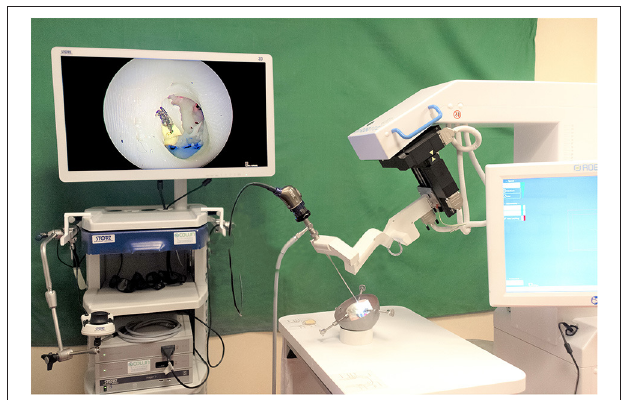
FIGURE 1 | RobOtol System in endoscope holder configuration with an artificial temporal bone. The RobOtol System (Collin, Bagneux, France) is a tele-operated arm that can bear instruments or an endoscope. It can be connected to any HD camera system (Here a Image1 Storz HD endoscopy column, Karl Storz, Tuttlingen, Germany). The robot is composed of a cart bearing the arm, a display screen used to change speed and control settings. The device is driven by a space mouse (3D Connection, Waltham, MA, USA, not shown here).